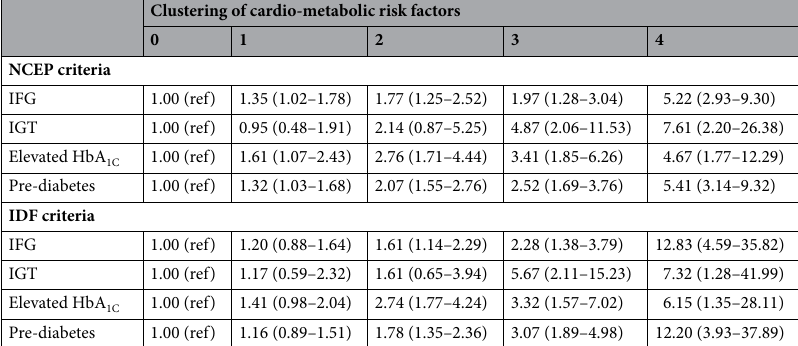
Table 3. Odds ratios (95% CI) of pre-diabetes according to clustering of cardio-metabolic risk factors. Adjusted for sex, age, race/ethnicity, and survey